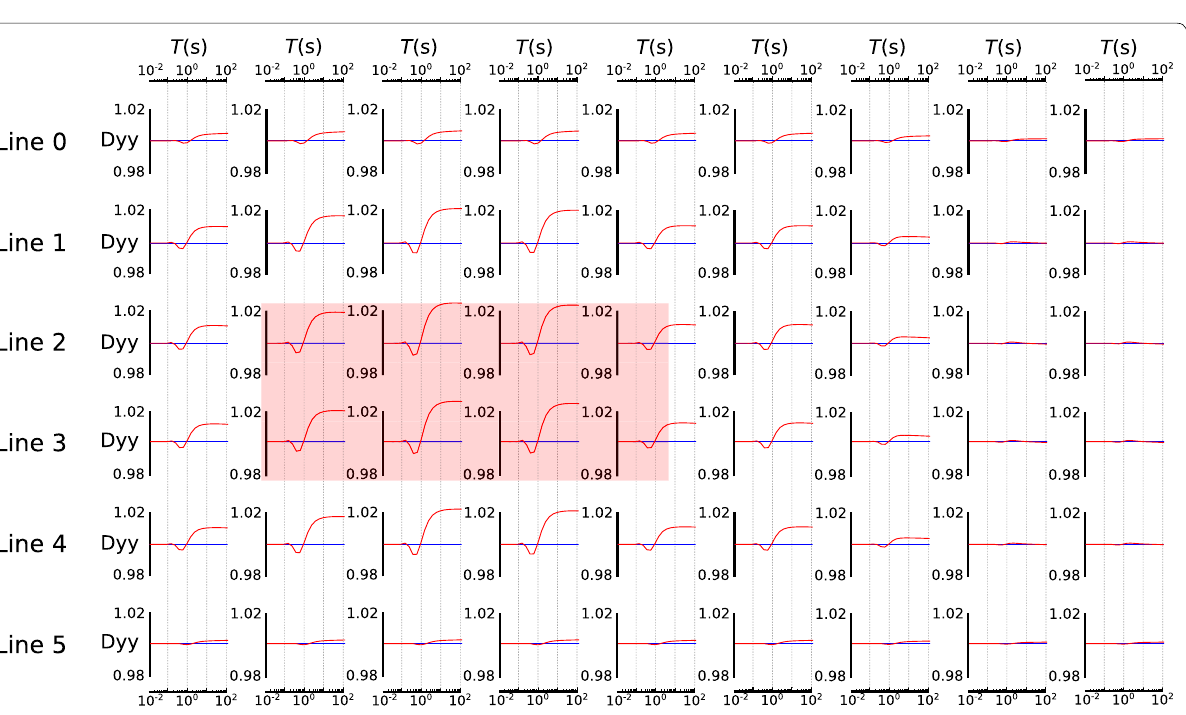
Fig. 6 Synthetic transfer functions ( D yy ) for the six